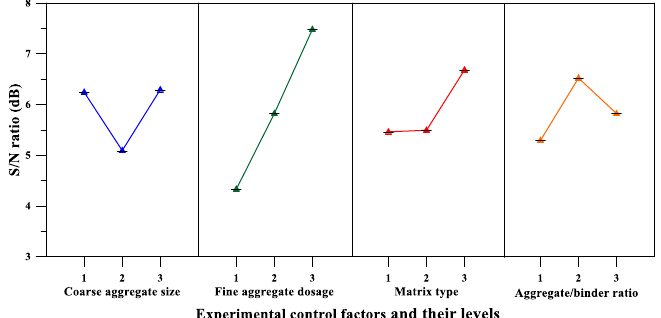
Figure 14. Relationship between splitting strength and void content.